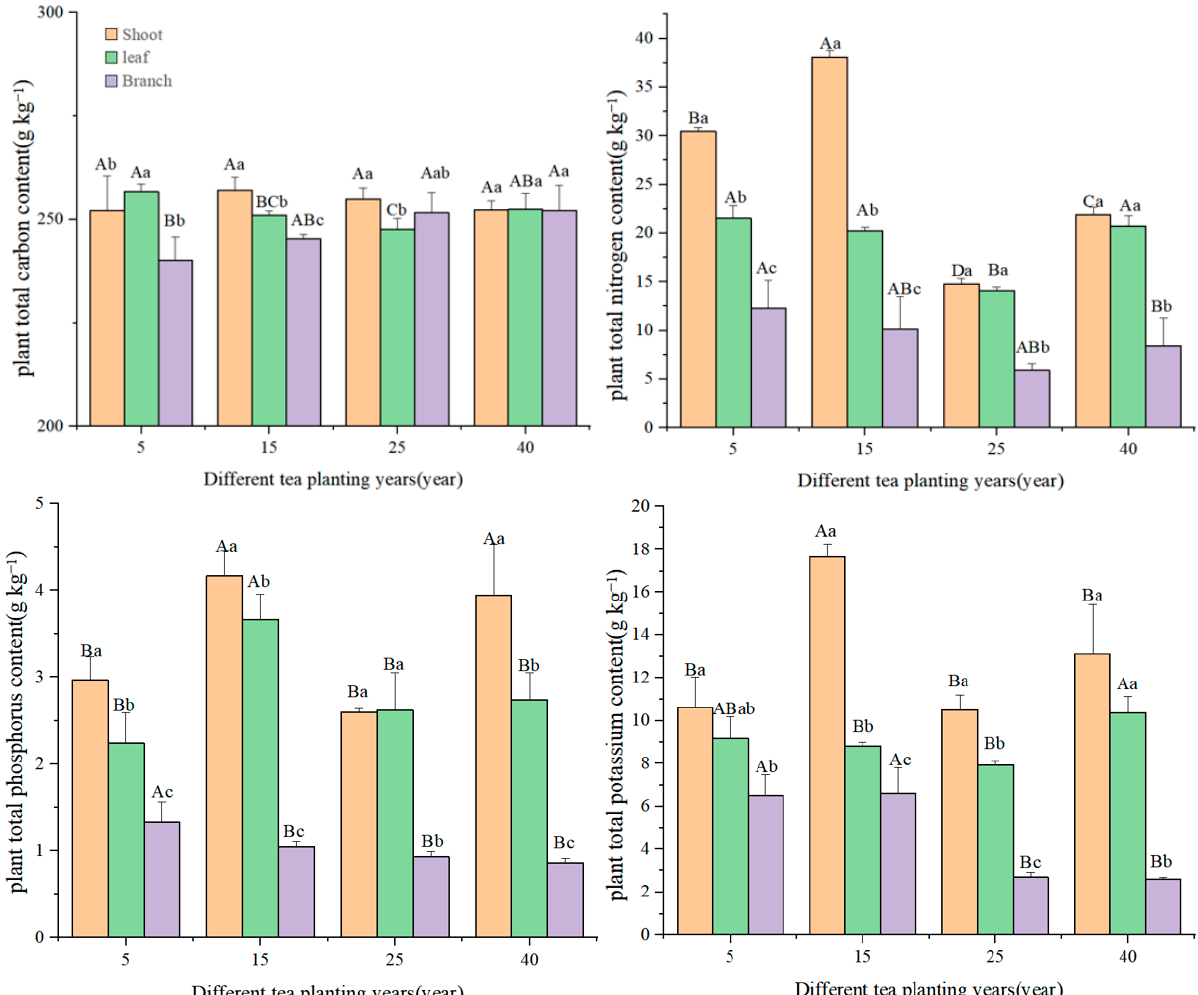
Figure 3. Nutrient characteristics of tea plants under di ff erent tea-planting years. Di ff erent capital le tt ers indicate signi fi cant di ff erences between planting years, di ff erent lowercase le tt ers indicate signi fi cant di ff erences between di ff erent parts ( p < 0.05).